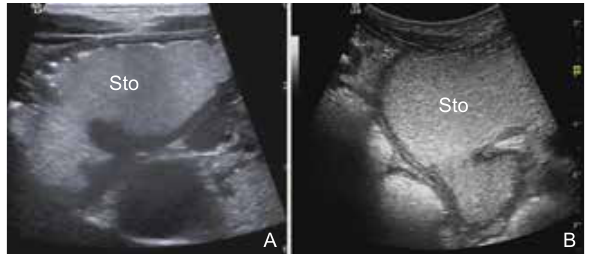
Figure 11 Contrast ultrasound imaging shown gastric polyps (arrows). (A) Inflammatory polyp; (B) Hyperplastic polyp. Po, polyp; Sto, stomach.